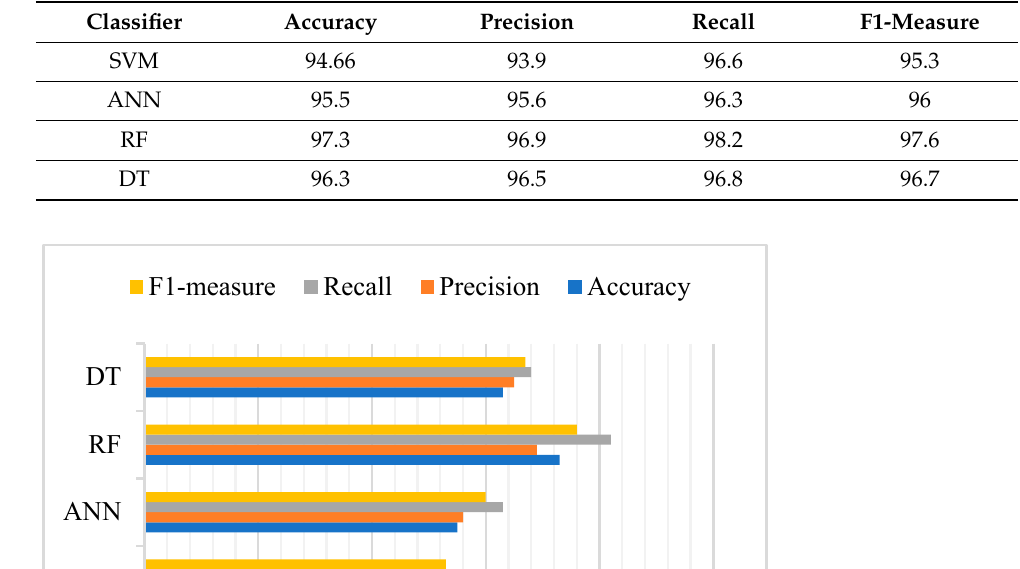
Table 4. Evaluation results in (%).